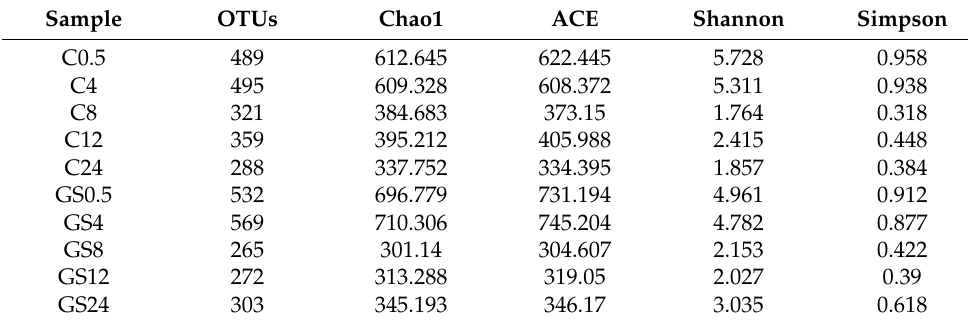
Table 2. Alpha-diversity values of samples.